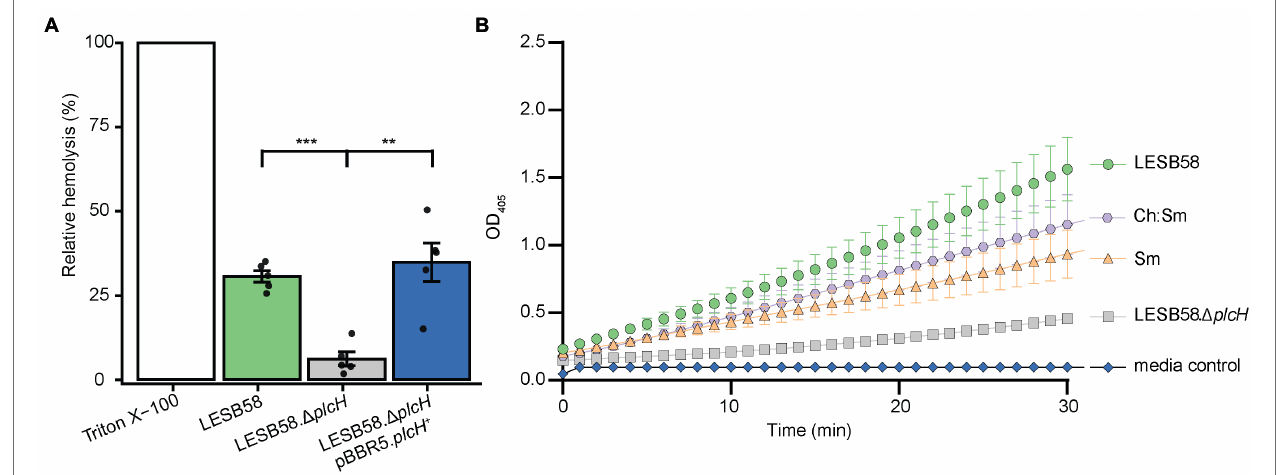
FIGURE 2 | Pseudomonas aeruginosa supernatant-induced hemolysis is attenuated by the removal of phospholipase C and supernatants pre-incubated with liposomes have reduced hemolytic phospholipase C activity. (A) RBCs were treated with 100 μ l of filter-sterilized supernatant from 24-h cultures of bacterial strains grown in MEM + 1% FBS incubated at 37 ° C. OD 450 was measured for each strain and normalized to control untreated RBCs and fully lysed RBCs (treated with 2% v / v Triton X-100). One-way ANOVA with post-hoc Dunnett test, **Bonferroni correct value of p < 0.01, and ***Bonferroni corrected value of p < 0.001, n = 5, error bars represent ±SE. (B) The hemolytic phospholipase C driven hydrolysis of colorless p- nitrophenylphosphorylcholine to yellow p- nitrophenol was assessed for supernatants pre-treated with 300 μ g/ml cholesterol-containing (Ch:Sm) and sphingomyelin only (Sm) liposomes or vehicle control (LESB58 wild type, LESB58. Δ plcH ; six independently prepared wild-type supernatants for LESB58, Sm, Ch:Sm; three independently prepared LESB58. Δ plcH bacterial supernatants). Error bars are mean ± SE; SE not shown for mutant and media control due to very small variation. A two-way ANCOVA with post-hoc Bonferroni value of p adjustment was carried out using the wild-type (LESB58) phospholipase C activity as a control. All conditions were significantly different, adjusted value of p of 0.031 for Ch:Sm, and p < 0.0001 for all other